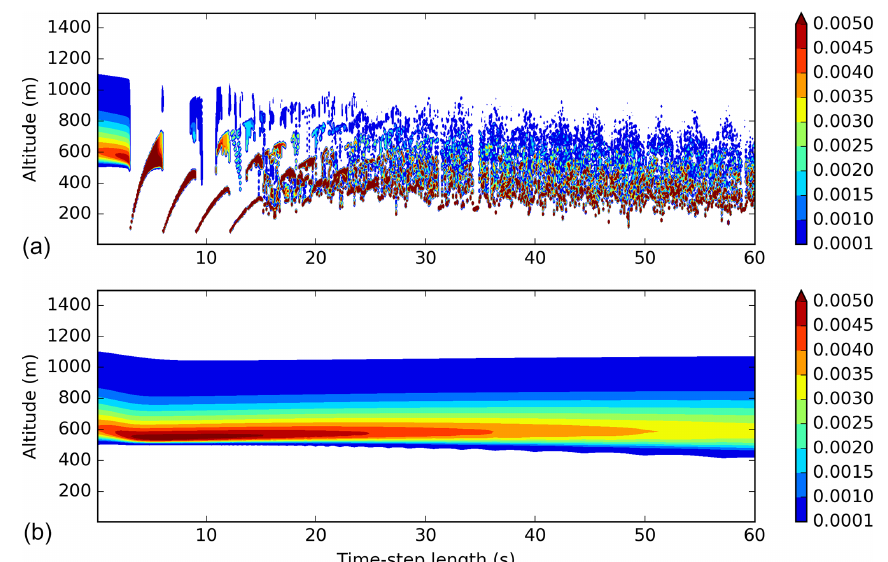
Figure 13. Same as Fig. 11 but for the box-Lagrangian scheme using the bulk approach (a) and an hybrid approach (b) . The color scale represents the mixing ratio in gkg − 1